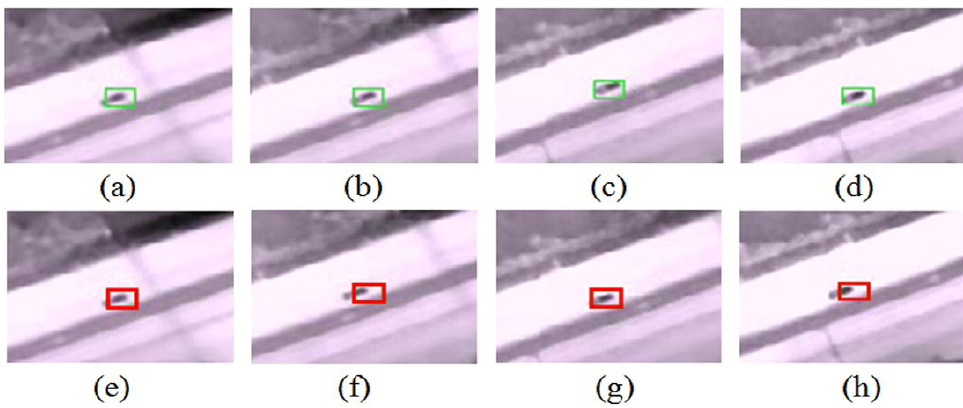
Figure 8. Comparison of results of target tracking by MSDU and MS for Sequence A. Green rectangles are used in parts ( a – d ) respectively to represent the results obtained using MSDU in the 30th, 60th, 90th and 120th frames; red rectangles are used in parts ( e – h ) to represent the corresponding results obtained using MS.